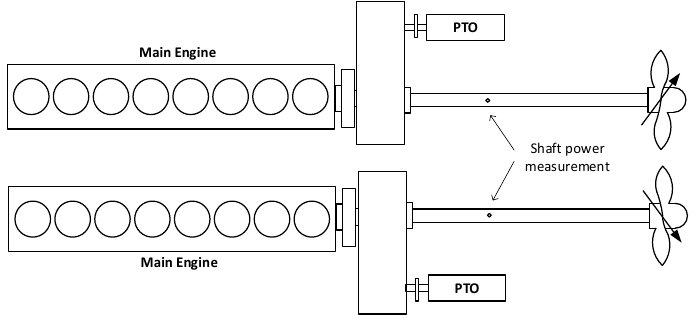
Figure 11. Ship main propulsion layout.